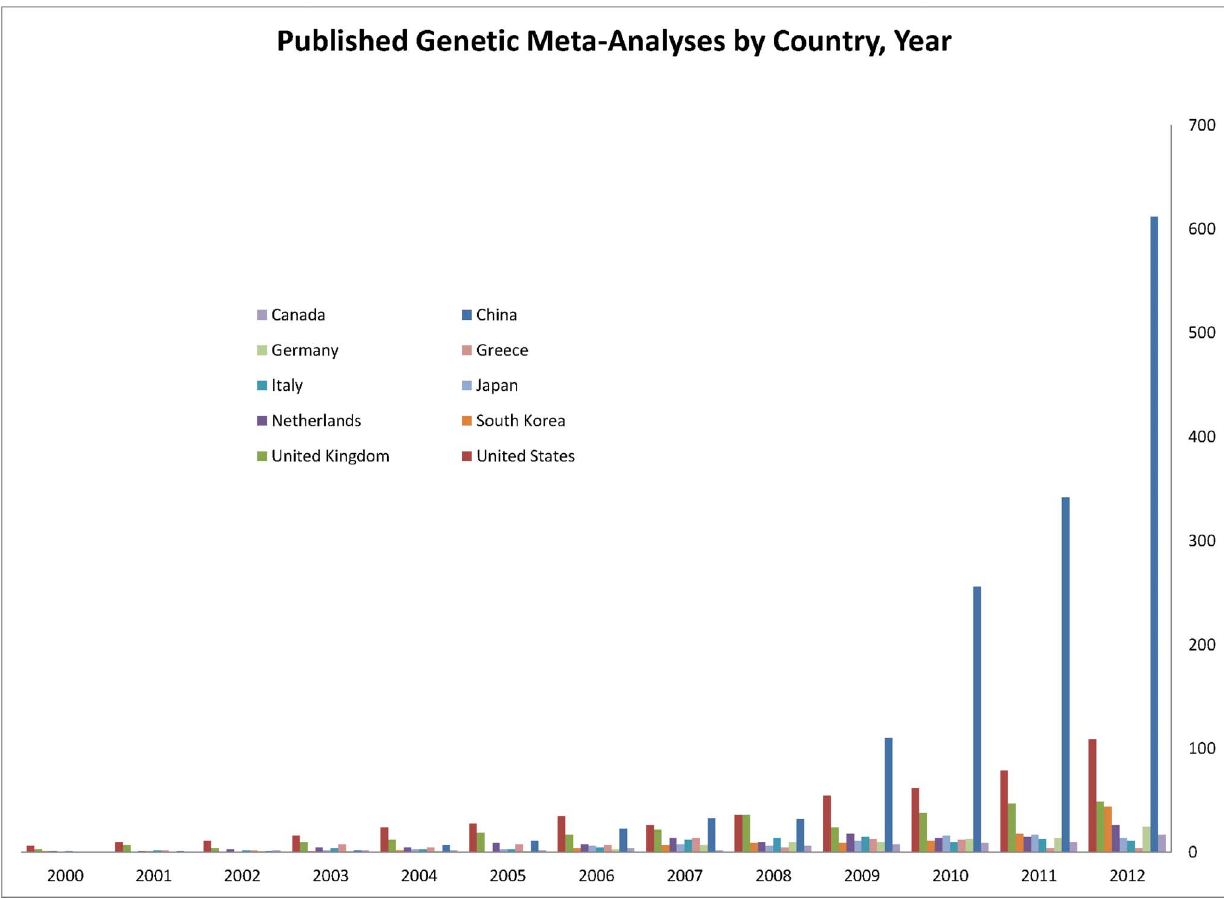
Figure 1. Annual number of meta-analyses of genetic associations for the 10 most-prolific countries in the period 2000 – 2012; data are derived from HuGE Navigator (last update January 13, 2012).